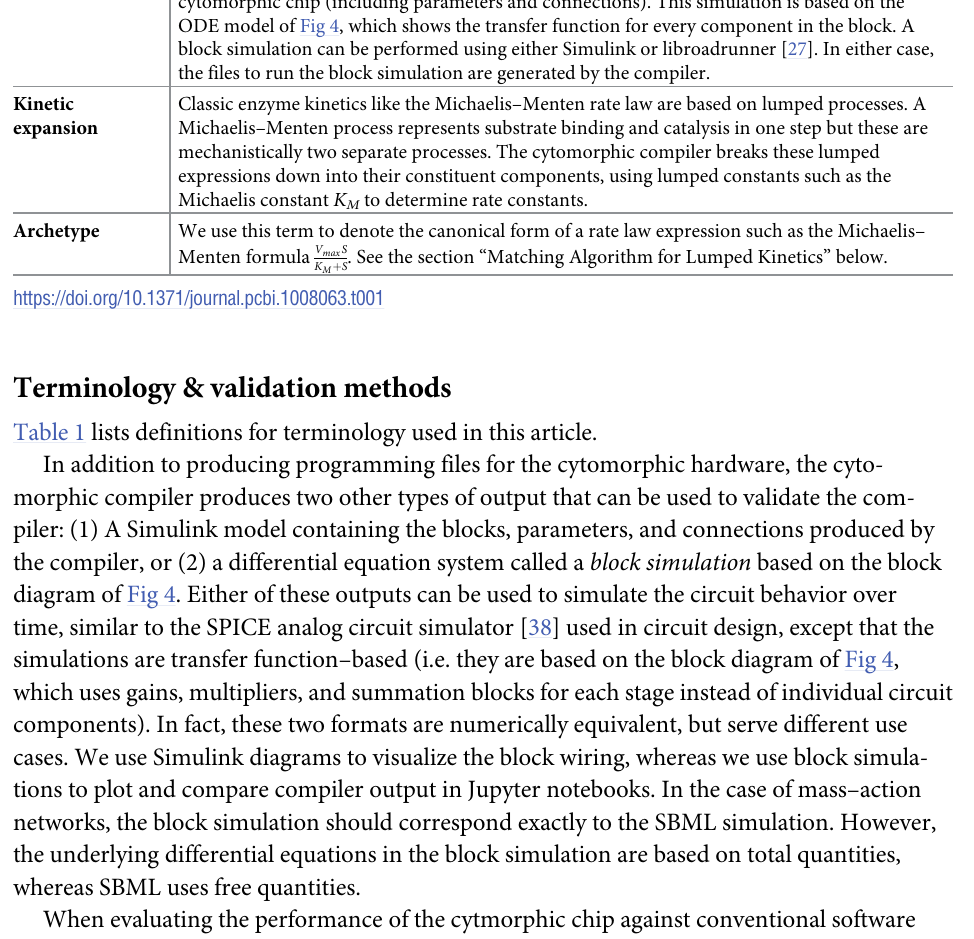
Table 1. Terminology used in this